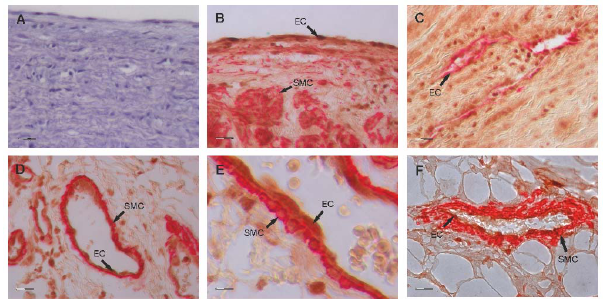
Figure 2. Gremlin-1 expression on aortic tissue of LDS patients. Paraffin-embedded aortic tissue specimen of LDS patients (n=3) were double stained with anti-Gremlin-1 (brown staining) and anti-CD34 (red staining; C) or anti-smooth muscle actin (red staining; B, D–F). Endothelial cells throughout the vessel wall showed expression for Gremlin-1 including ECs of the intima (B) and of vessels within the media (C) and the adventitia (D and in more detail in E). Gremlin-1 positive staining was also observed on smooth muscle cells of the media (B, C) as well as on vessel surrounding smooth muscle cells in the adventitial layer (D, E). In aortic tissue specimen of healthy controls (n=3), a similar staining pattern without gross differences of staining intensity was observed as shown for a small vessel within the adventitia (F). In A, an isotype control instead of primary antibody was used revealing the specificity of the staining (EC = endothelial cell,